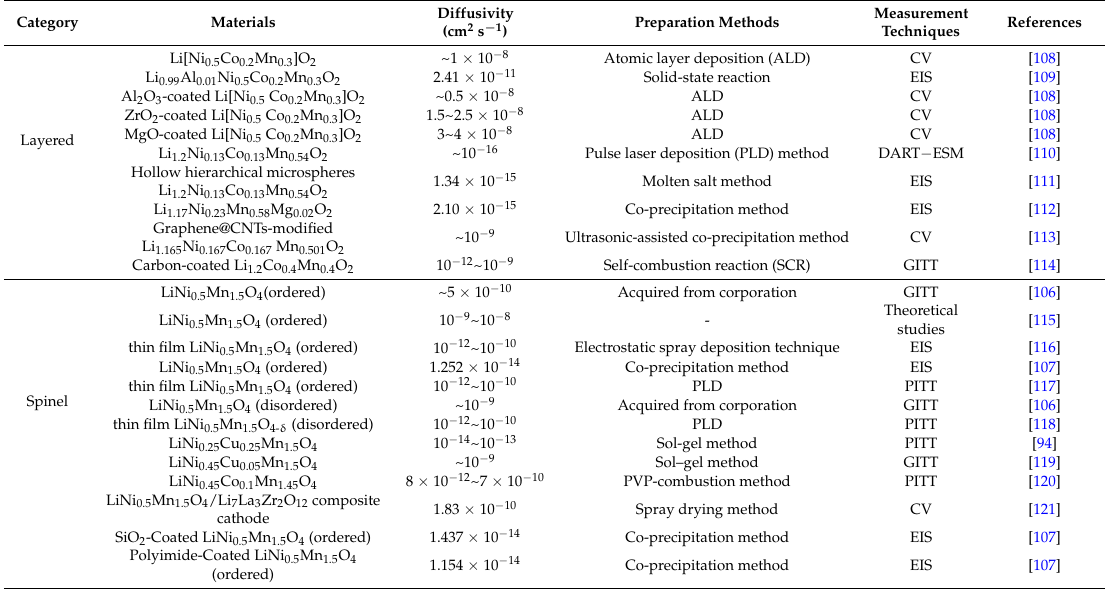
Table 6. Lithium diffusion coefficients of layered and spinel Mn-based